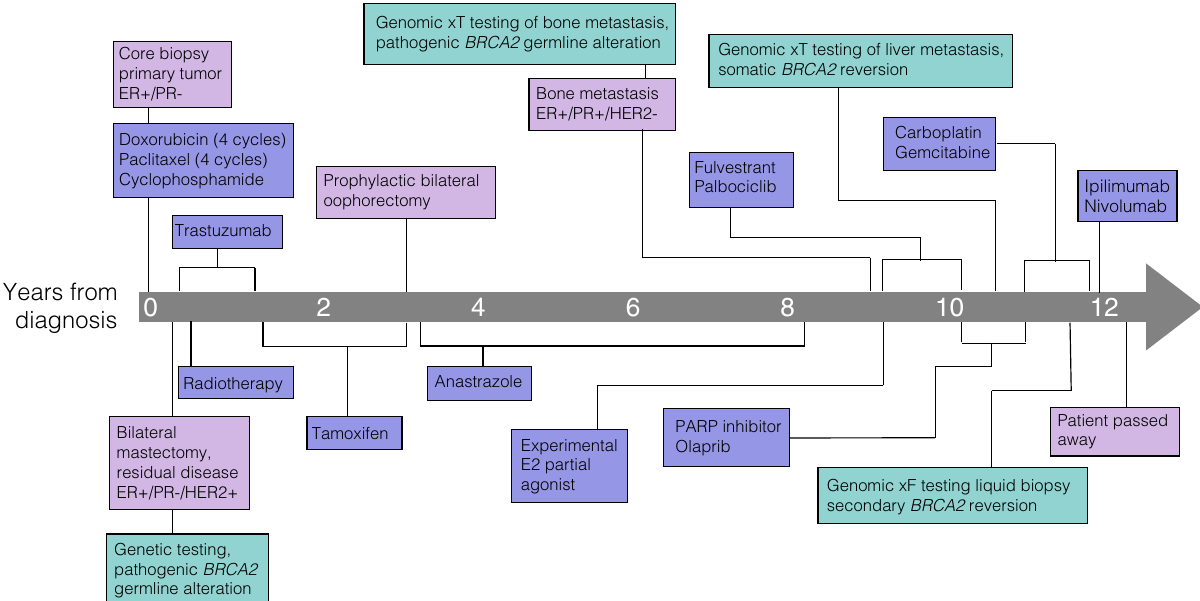
Fig. 1 Timeline of patient procedures, treatments, and disease progression. Green boxes denote genomic testing, purple boxes denote treatments, and pink boxes denote clinical timepoints and diagnostic